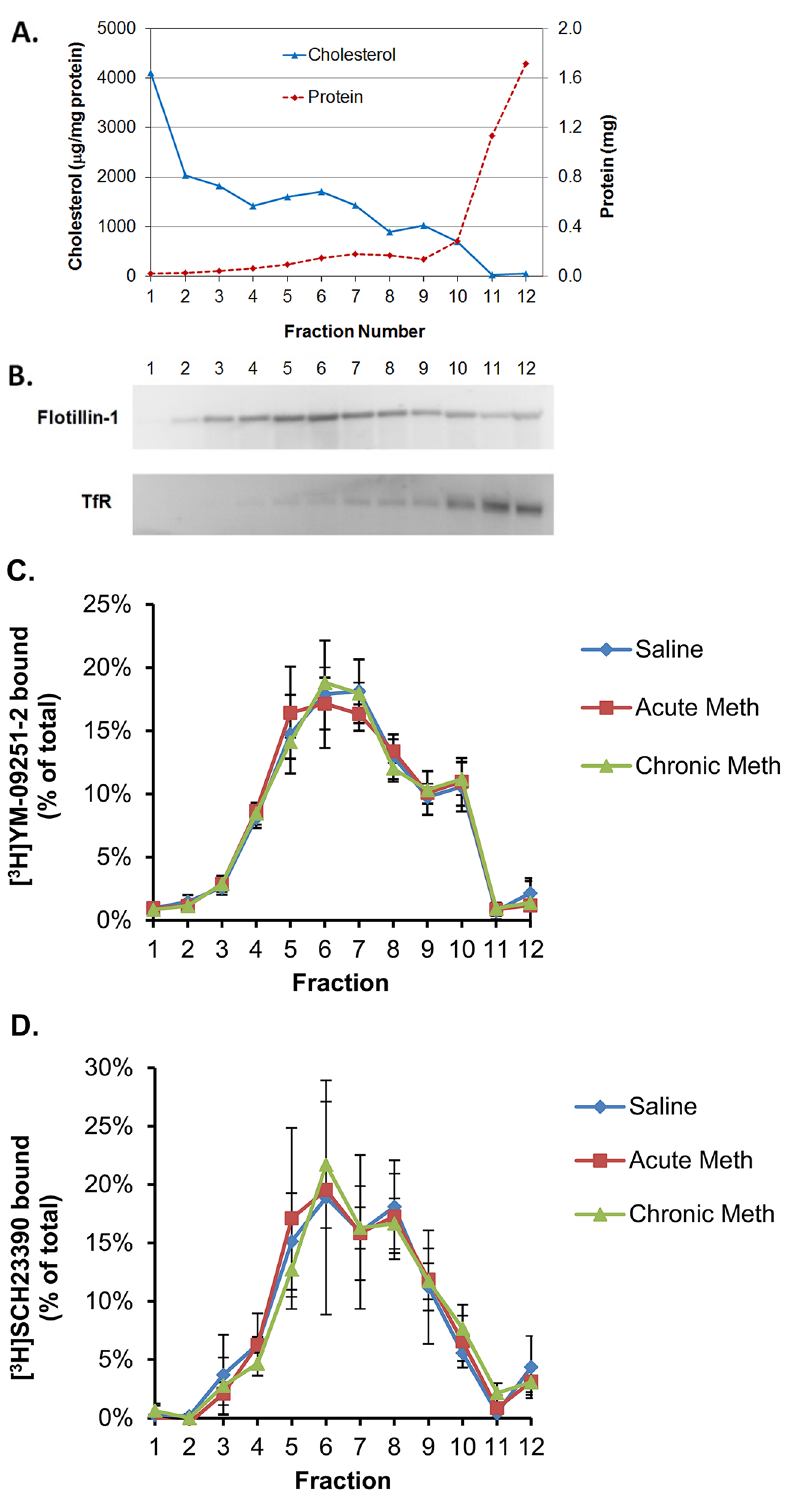
Fig 1. Dopamine receptors are enriched in striatal raft fractions but not affected by methamphetamine treatment. Membranes were prepared from rat striatal homogenates and separated by density gradient centrifugation. Results shown are representative of or the average of at least 3 independent experiments except where indicated. Raft fractions 4 – 7 were enriched in cholesterol (A), in flotillin but not transferrin